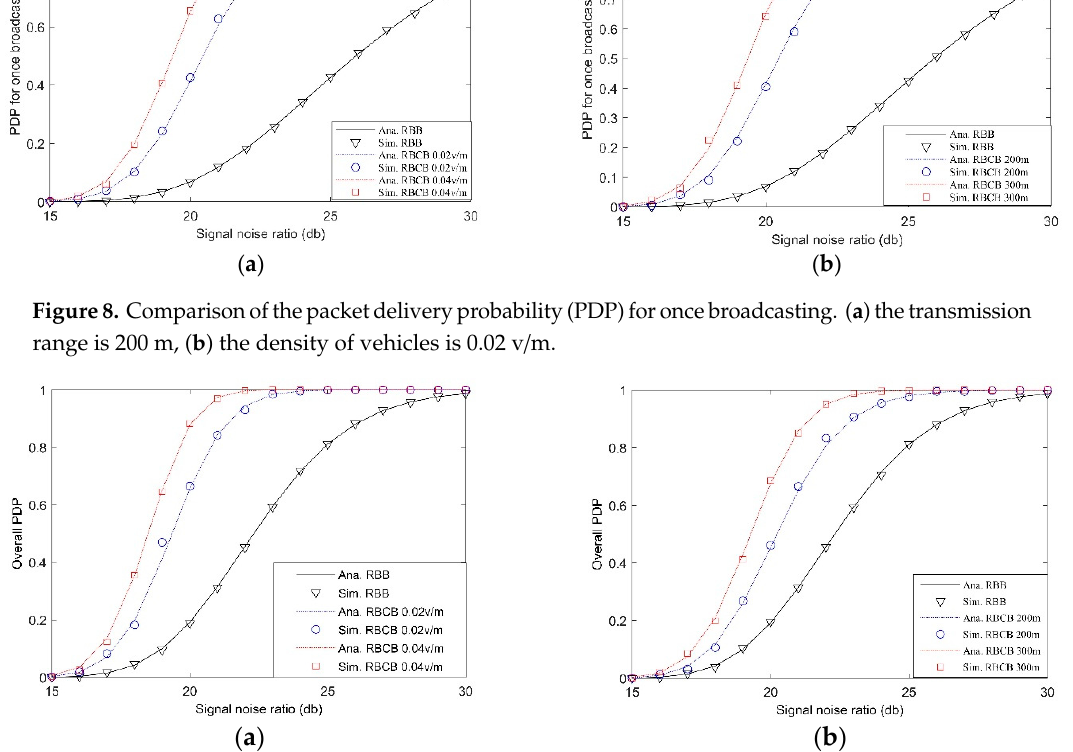
Figure 9. Comparison of the overall PDP. ( a ) the transmission range is 200 m, ( b ) the density of vehicles is 0.02 v/m.